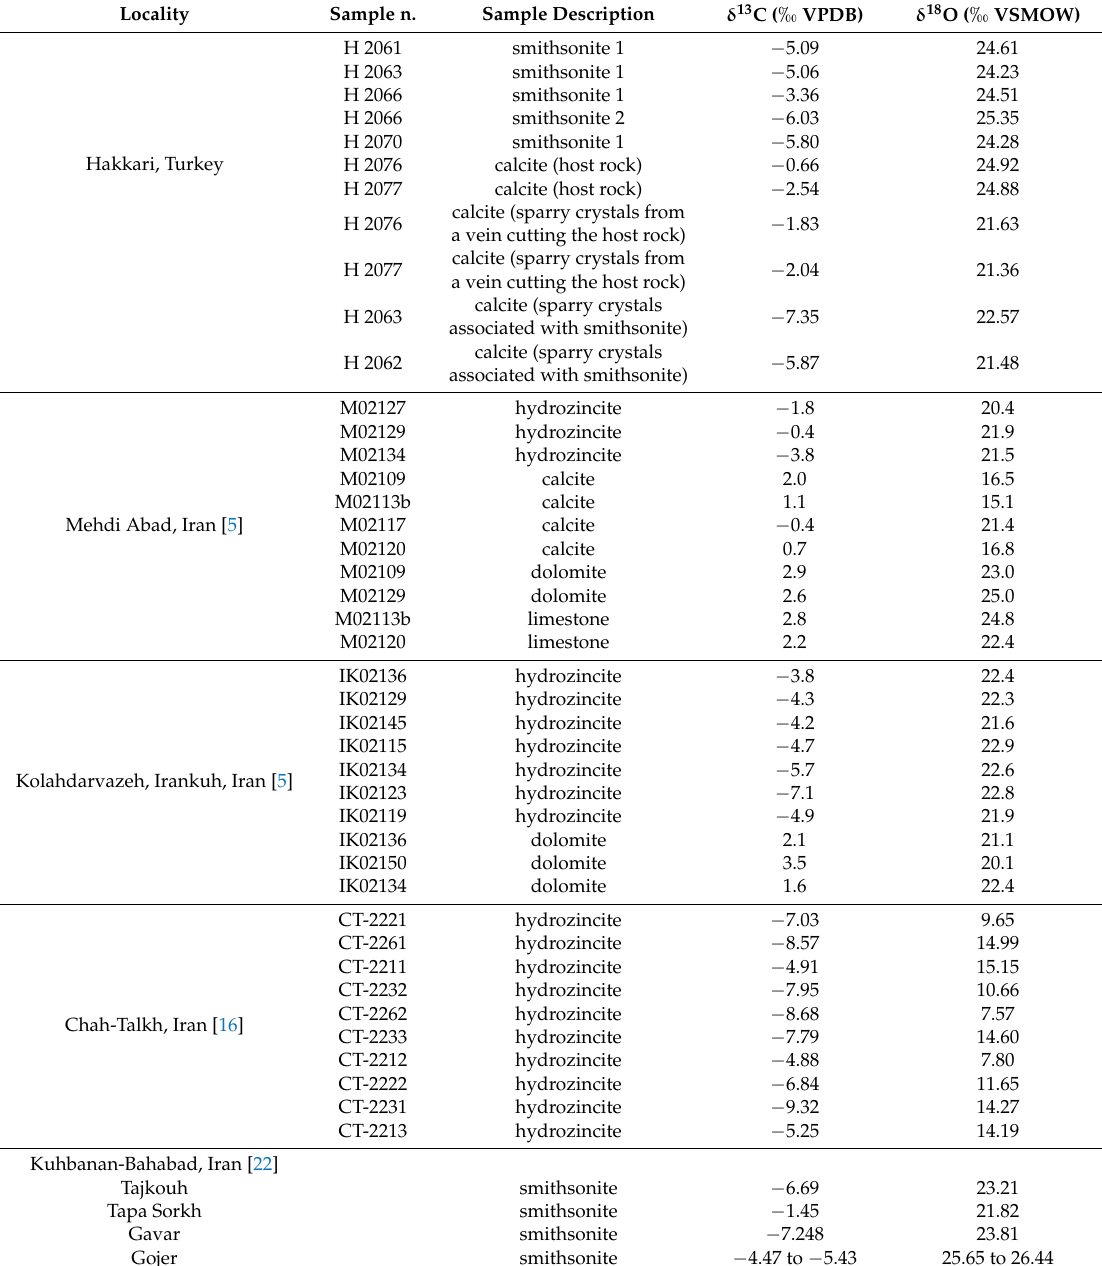
Table 1. Carbon and oxygen isotopes of carbonates in Zn nonsulfide deposits of Middle East. Locality Sample